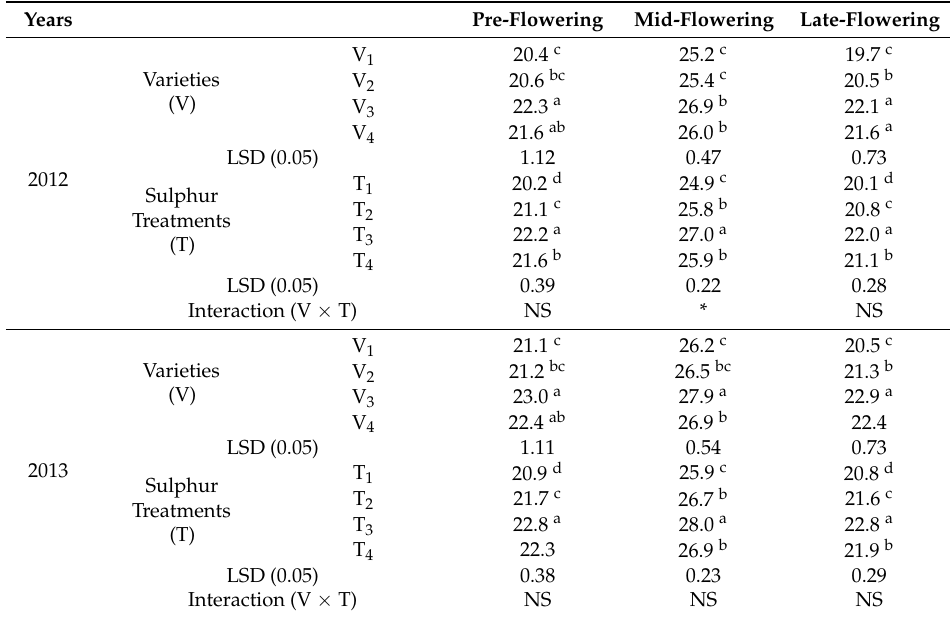
V 1 , V 2 , V 3 and V 4 represent four sesame varieties SG-27, SG-30, SG-36 and SG-51 and T 1 , T 2 , T 3 and T 4 , represent four sulphur treatments 20, 30, 40 and 50 kg S ha − 1 respectively. Means do not share the same letters in the column differ significantly at p ≤ 0.05; * = Significant; NS = Non-significant.